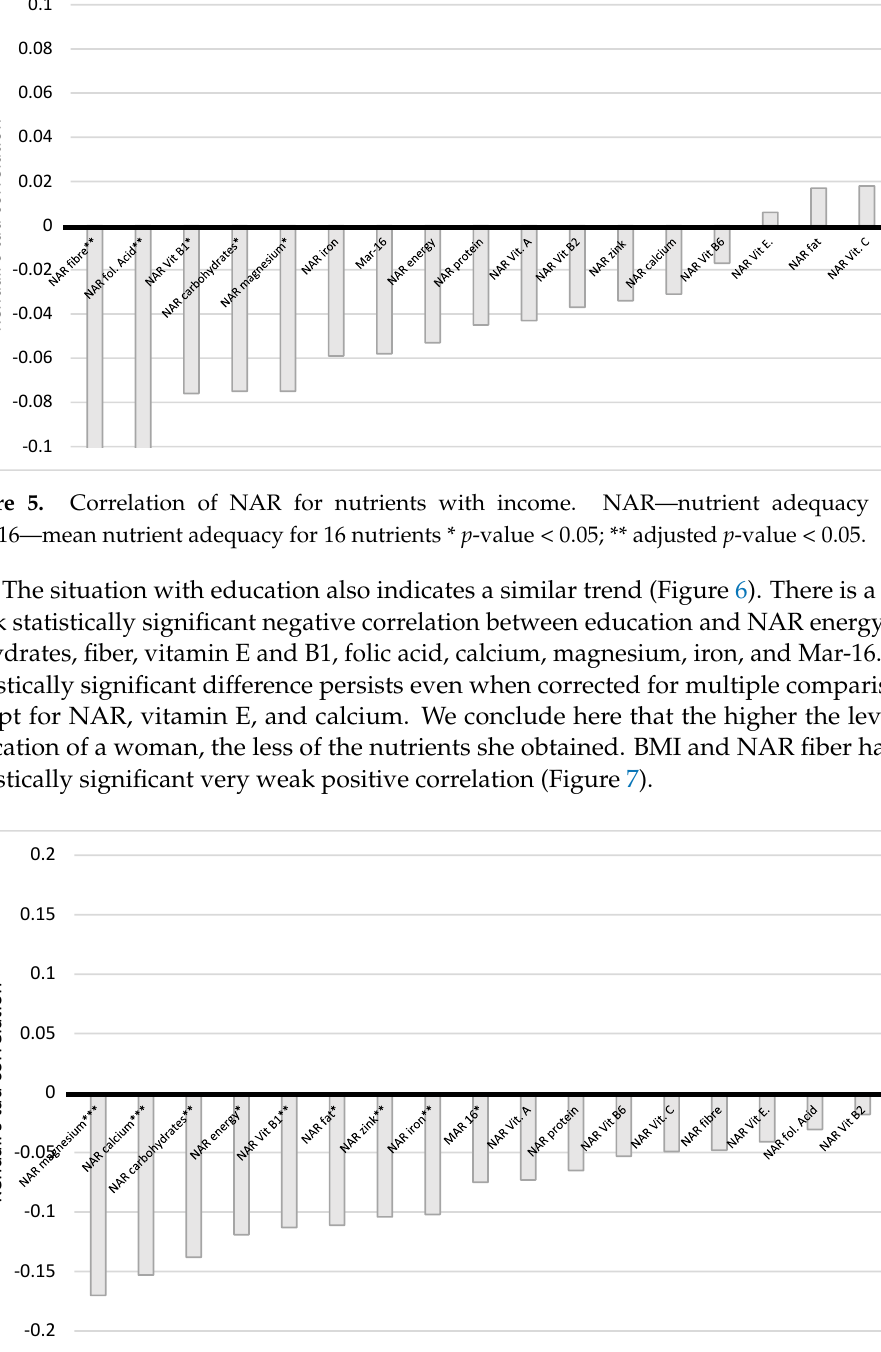
Figure 4. Determining factors for dietary diversity. The figure shows CLES-common language effect size in two groups. Group A includes urban residents; -northern region; remittances; non-Kyrgyz